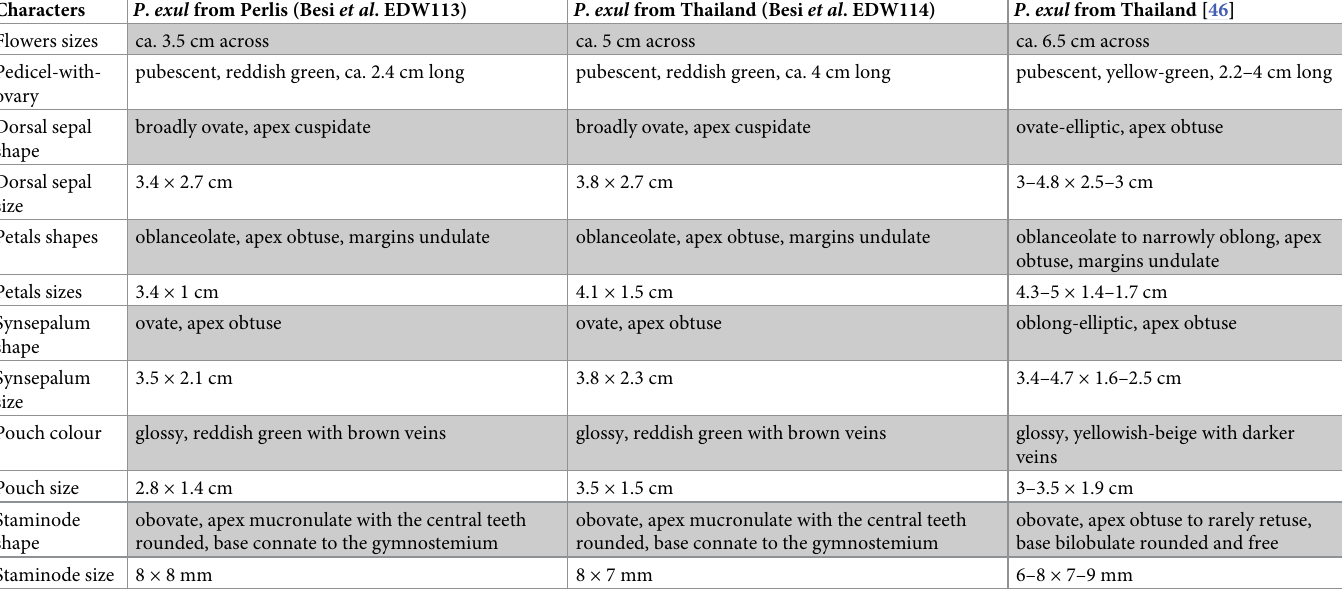
Table 1. Comparison of morphological characters of P . exul from Perlis and P . exul from